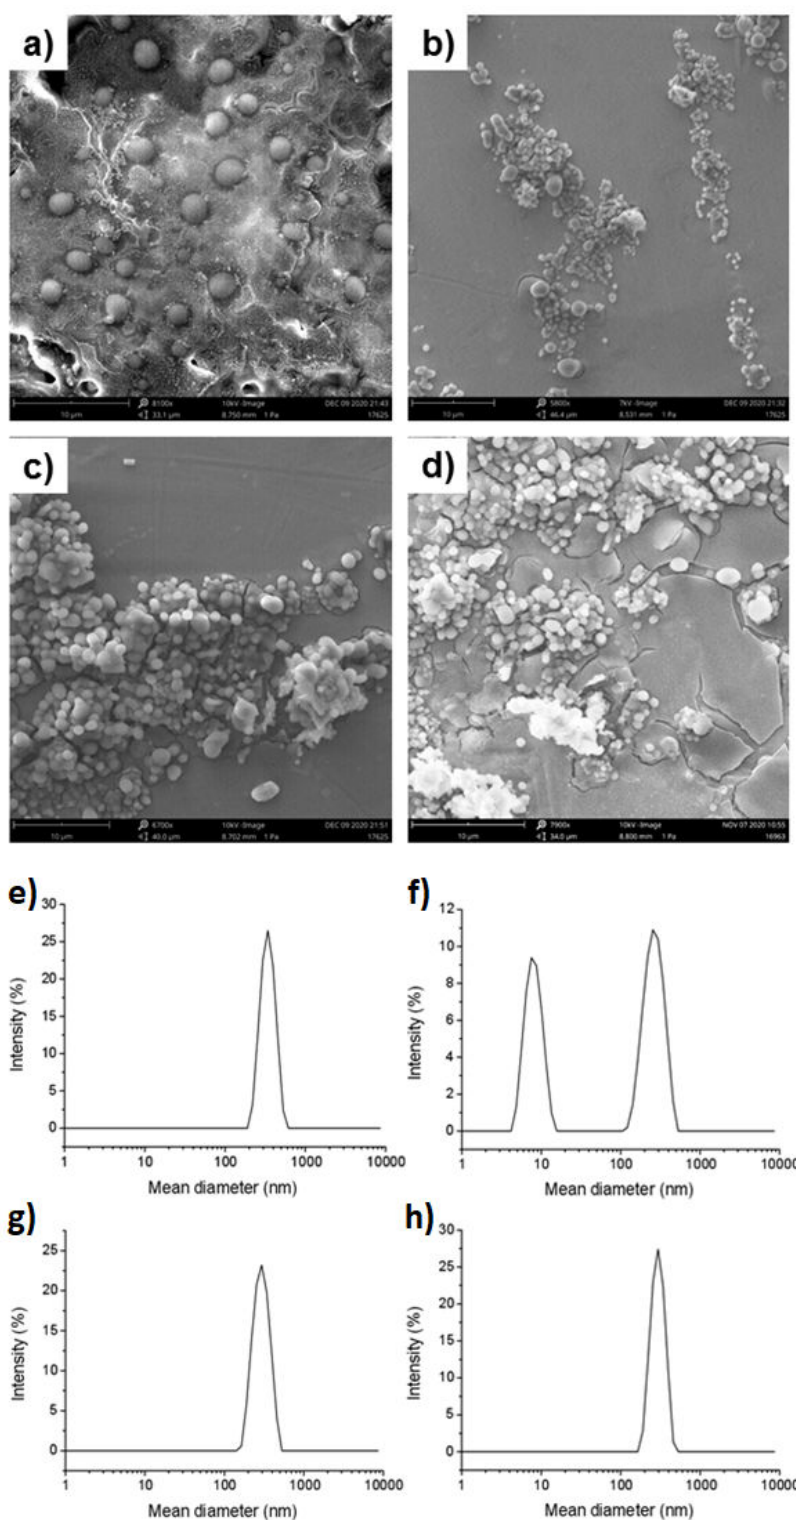
Figure 2. Characterization of primary and model cell line EVs. SEM micrographs of EVs drop-casted on aluminum stubs: ( a ) EVs from patient HER2+ BC #37; ( b ) EVs from FAD patient #44; ( c ) EVs from TNBC patient #148; and ( d ) MDA-MB-231 cell EVs. Magnification and scale bar for all samples is 7900 × , 10 µ m. Dynamic light scattering intensity profile of EVs in aqueous solution: ( e ) #37 EVs; ( f ) #44 EVs; ( g ) #148 EV; and ( h ) MDA-MB-231